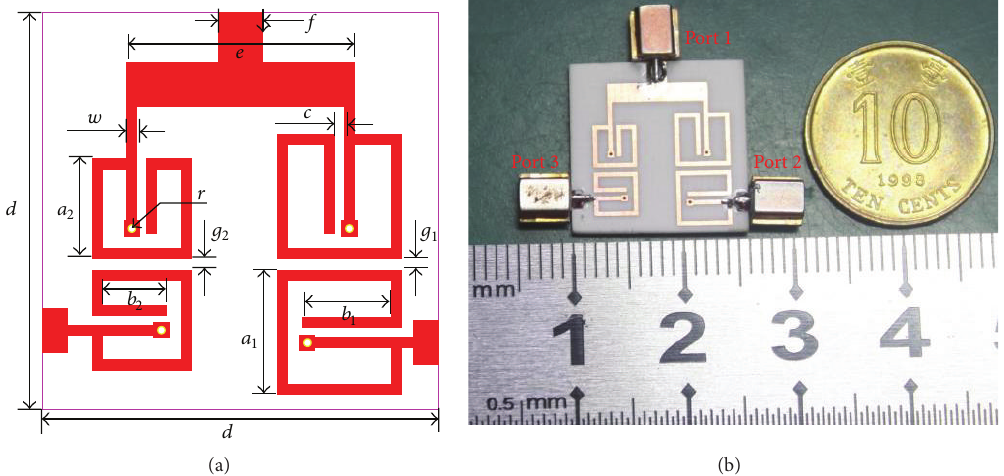
Figure 3: (a) The synthesized compact diplexer layout with dimensional parameters and (b) the photograph of fabricated diplexer.